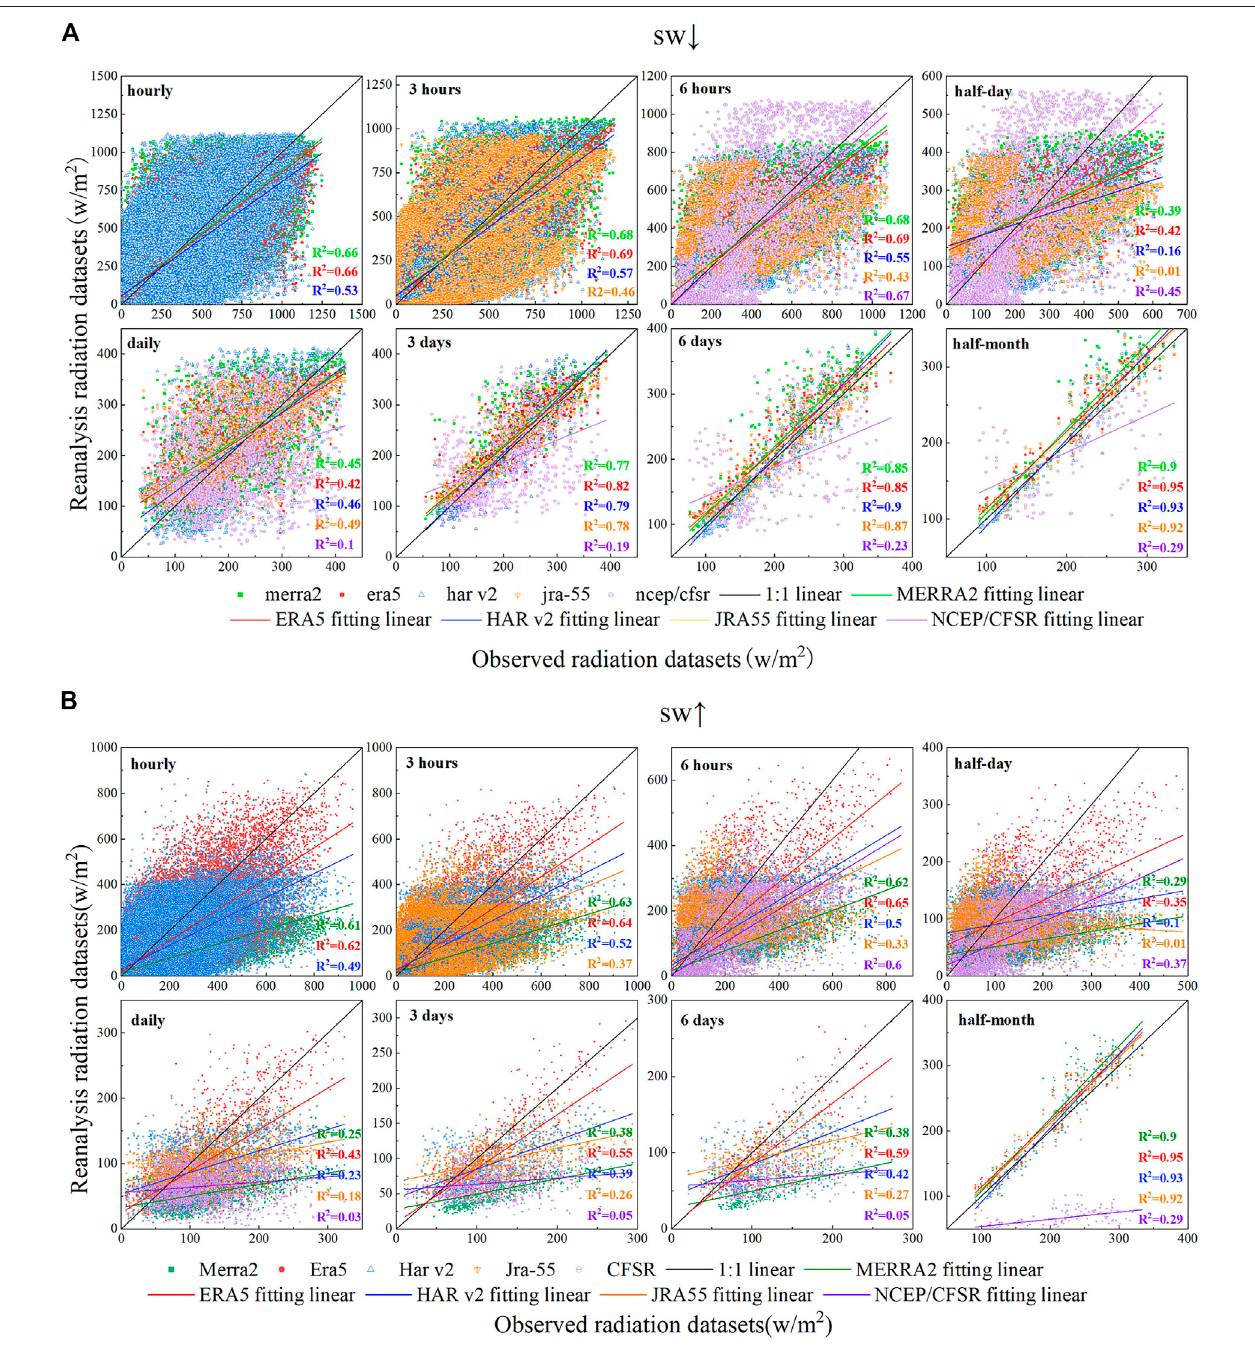
FIGURE 2 | 2010 – 2015 Scatter distribution of shortwave radiation observed datasets and reanalysis datasets on different time scales; (A) and (B) represent downward shortwave radiation and upward shortwave radiation, respectively.